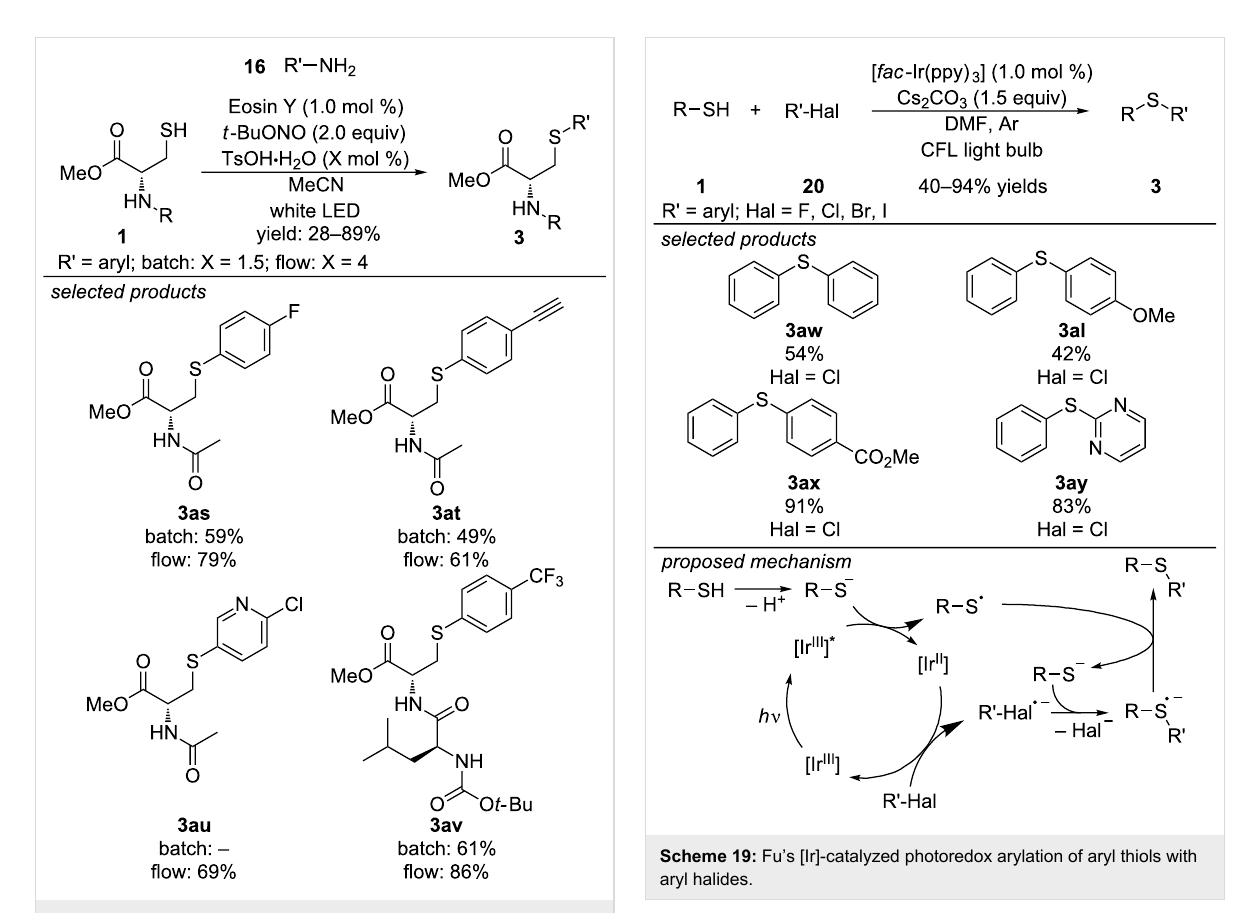
Scheme 18: Photocatalyzed cross-coupling of aryl diazonium salts with cysteines in batch and in a microphotoreactor.